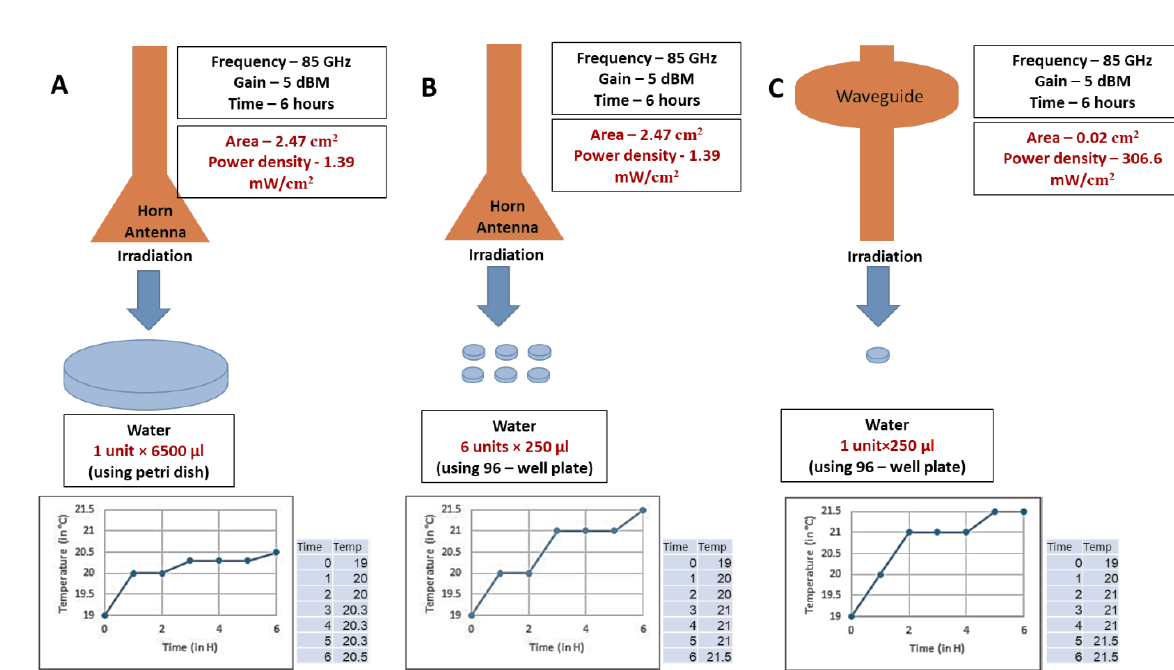
Figure 4. Comparison of temperature rise during 85 GHz MMW exposure at constant power and treatment duration, involving horn antenna and wave-guide. Indicated volumes of water were irradiated as illustrated. ( A ) Temperature rise of 6500 µ L water during MMW exposure at 1.39 mW/cm 2 . ( B ) Temperature rise of 250 µ L water during MMW exposure at 1.39 mW/cm 2 . ( C ) Temperature rise of 250 µ L water during MMW exposure at 17.17 mW/cm 2 . Frequency, power and duration of exposure were kept constant at the values in the specific experiments as indicated.